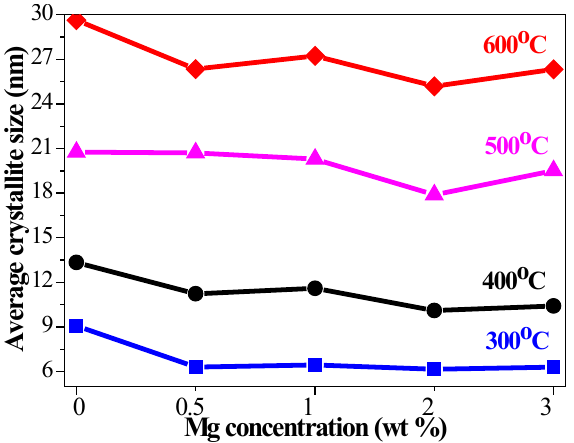
Figure 3. Average crystallite sizes of the sol–gel ZnO and ZnO:Mg films as a function of magnesium concentration. The films are annealed at temperatures from 300 to 600 °C.